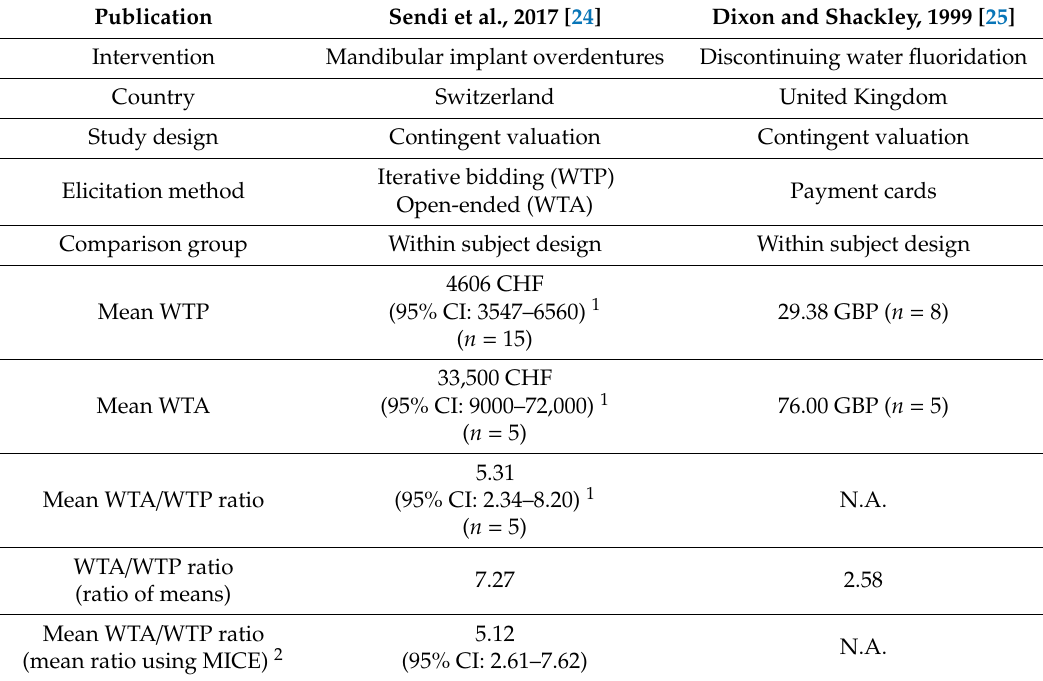
Table 1. Studies included for estimating the WTA / WTP